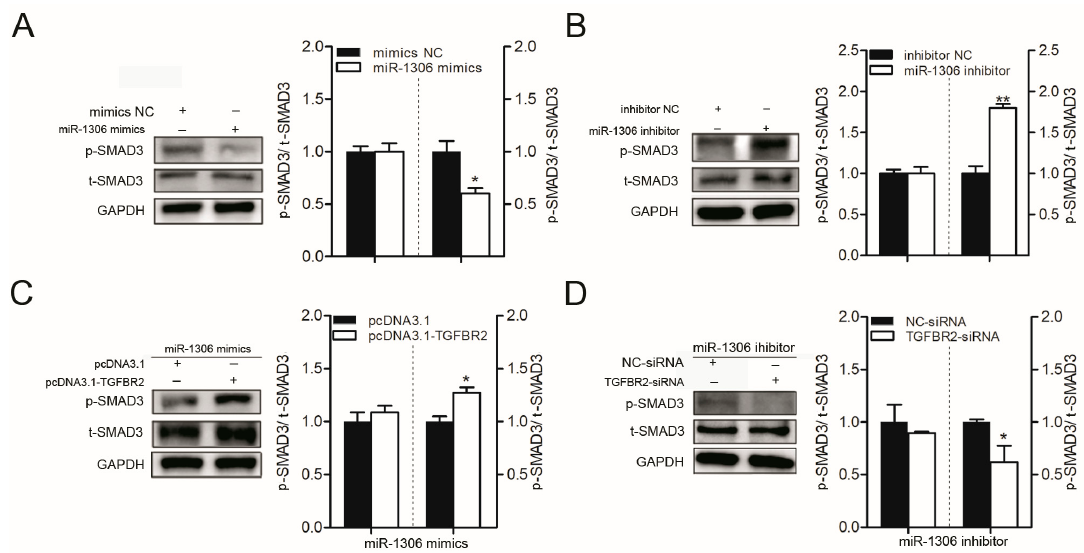
Figure 2. miR-1306 inactivates the transforming growth factor- β (TGF- β )/ SMA- and MAD-related protein (SMAD) signaling pathway in GCs by impairing TGFBR2. ( A , B ) Western blotting results showing levels of phospho-SMAD3 (p-SMAD3) and total-SMAD3 (t-SMAD3) protein after transfection of miR-1306 mimics or miR-1306 inhibitors into porcine GCs, respectively. ( C , D ) Western blotting results showing levels of p-SMAD3 and T-SMAD3 protein when both miR-1306 and TGFBR2 were overexpressed or silenced in porcine GCs. Each experiment has three independent repetition and results are shown as mean ± SEM. * indicates p < 0.05; ** indicates p < 0.01.